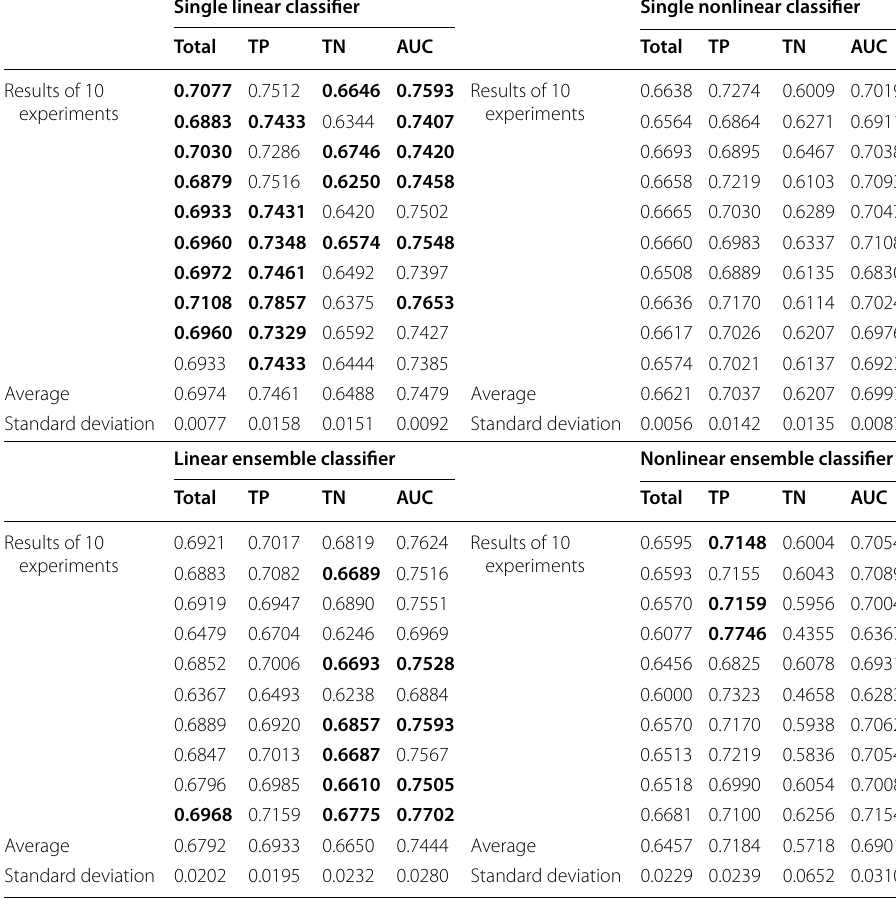
Table 4 Robustness analysis of classification with PCA in China Unionpay dataset when 100 < feature dimensions < sample